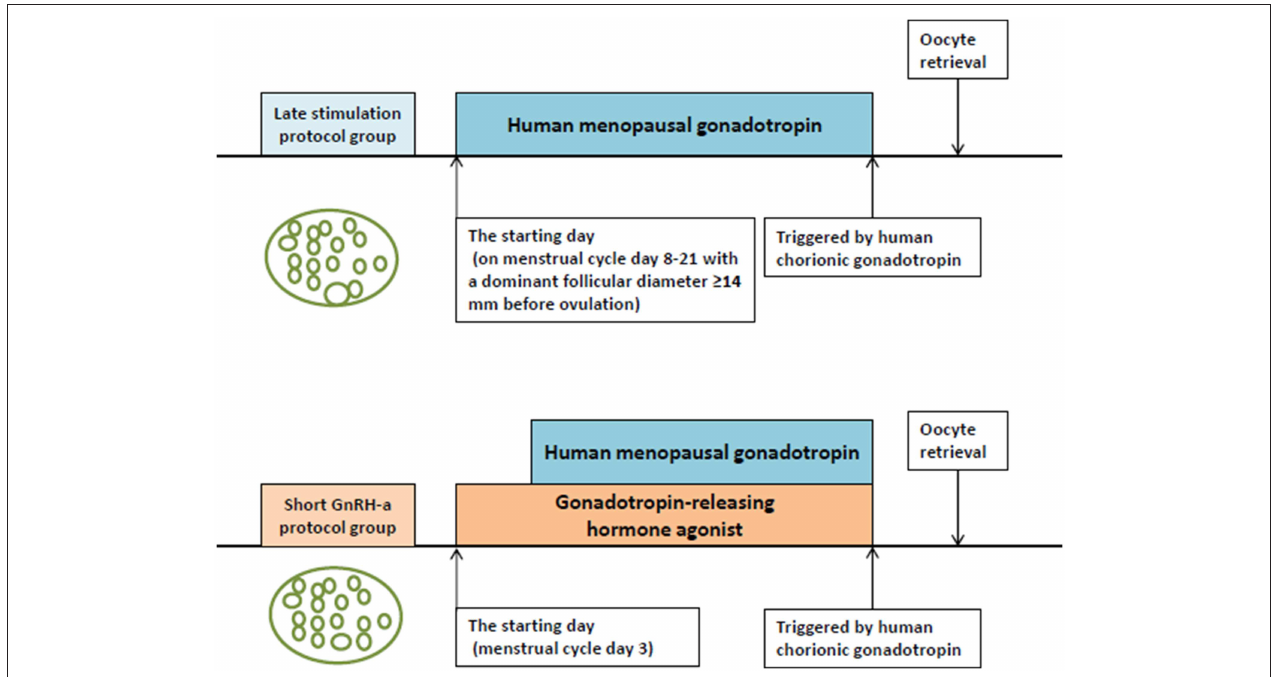
FIGURE 1 | The ovarian stimulation protocols adopted in the two groups.